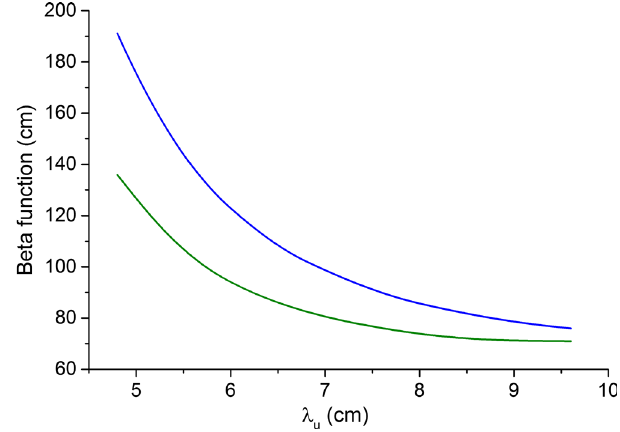
FIG. 17. Dependence of matched horizontal (blue) and vertical (green) β functions on undulator